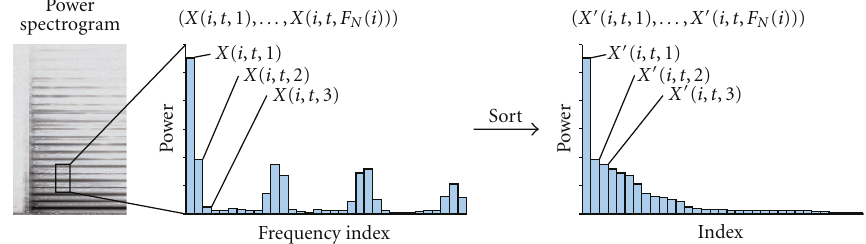
Figure 3: Sorted vector of power